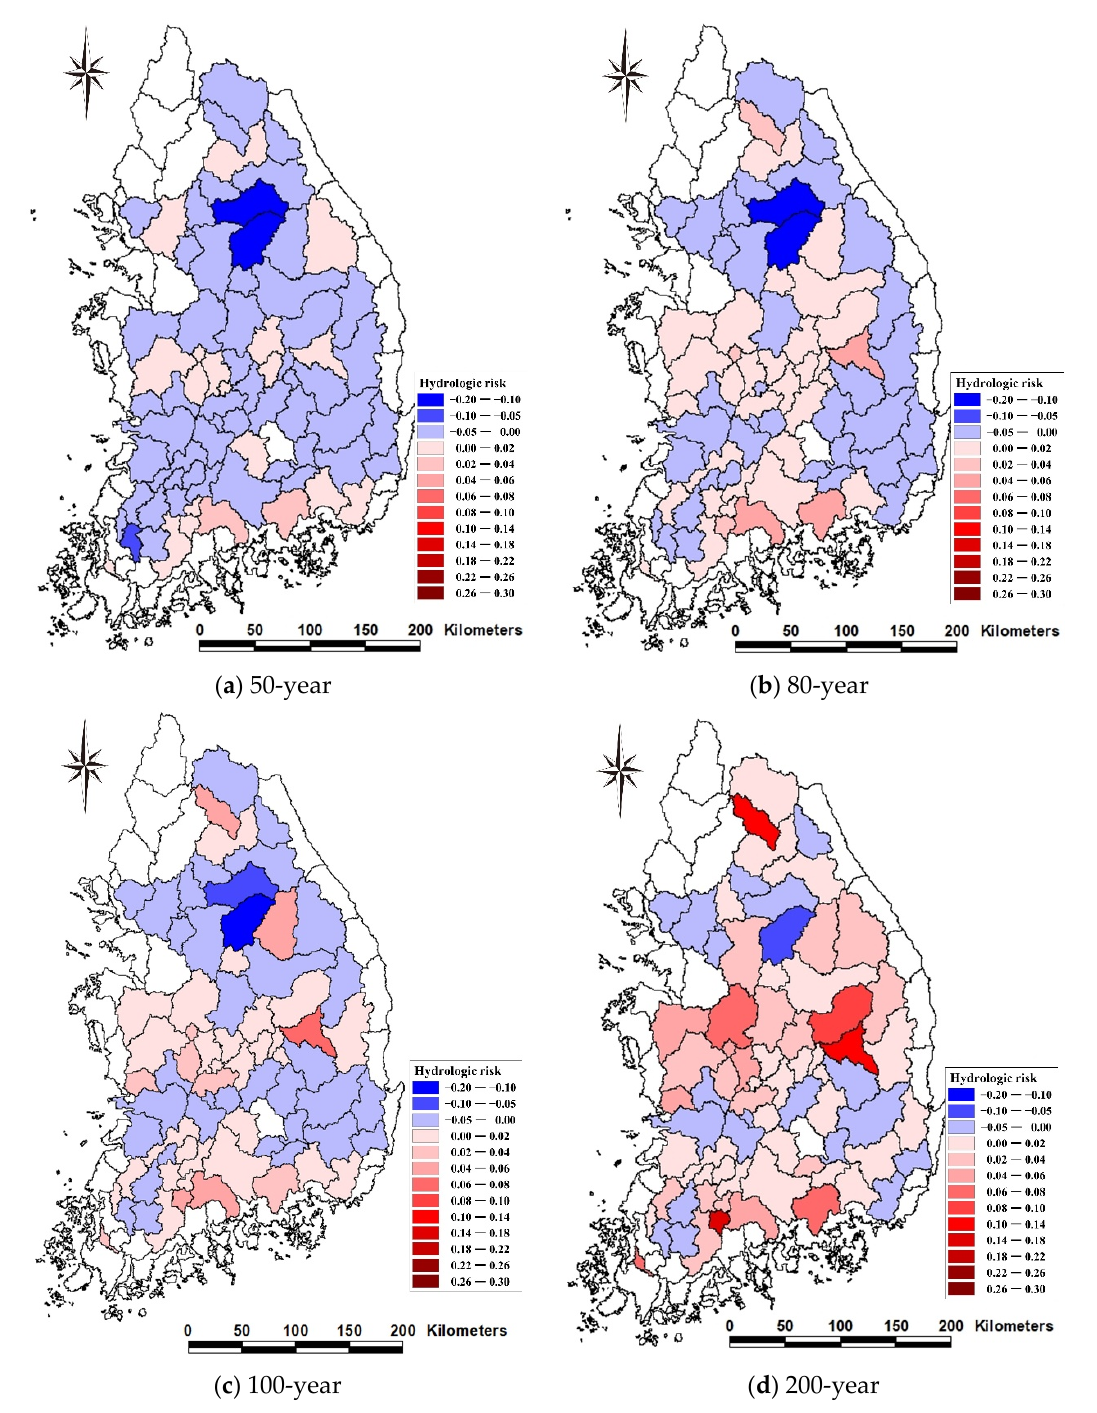
Figure 10. Hydrologic risk map of the RCP 4.5 for the total period.